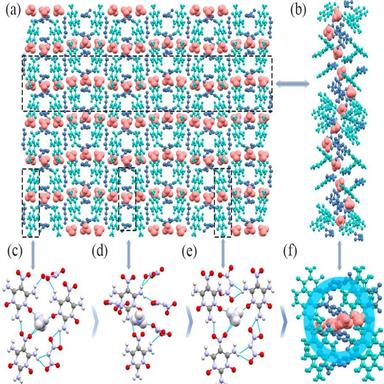
The packing of ADN/TANPDO supramolecular crystal: (a) The packing of ADN/ TANPDO supramolecular crystal. (b) The NH4 + ions with a chain-like configuration are interspersed in the encapsulation channels. (c)-(e) Three different ways in which NH4 + ions are encapsulated by TANPDO molecules and N (NO2)2 - ions. (f) The style of NH4 + ions encapsulated by TANPDO molecules and N(NO2)2 - ions.